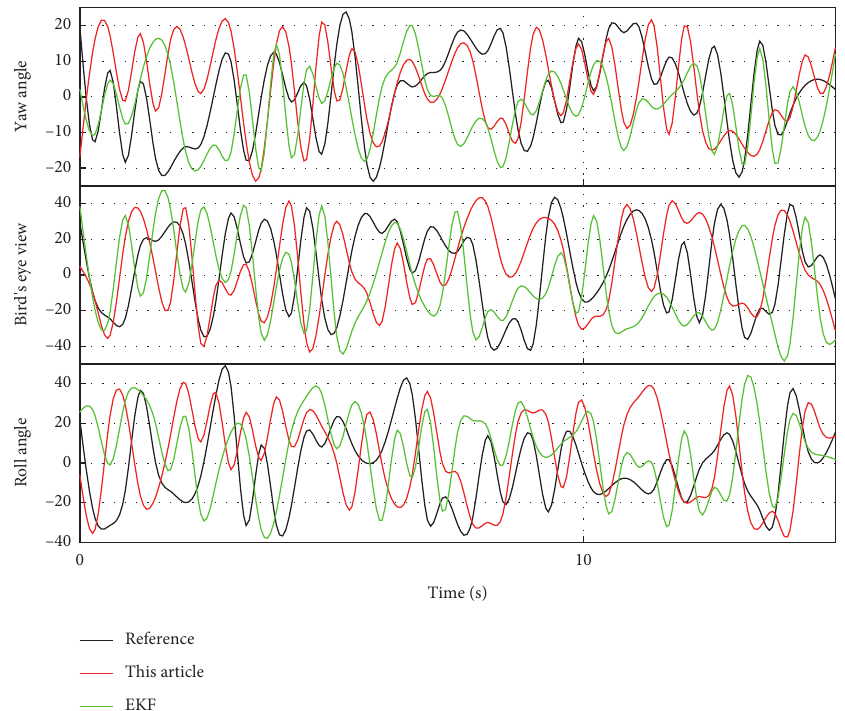
Figure 6: Comparison of attitude estimation errors of three attitude algorithms during normal rotation.